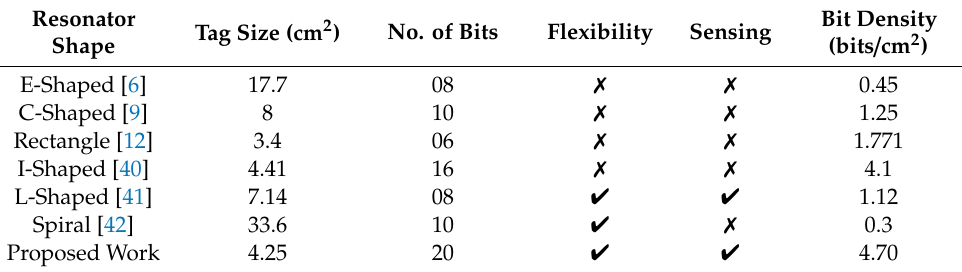
Figure 16. RCS response of the tag for moisture sensing. Table 2. Comparison of different RFID tags with the proposed work.